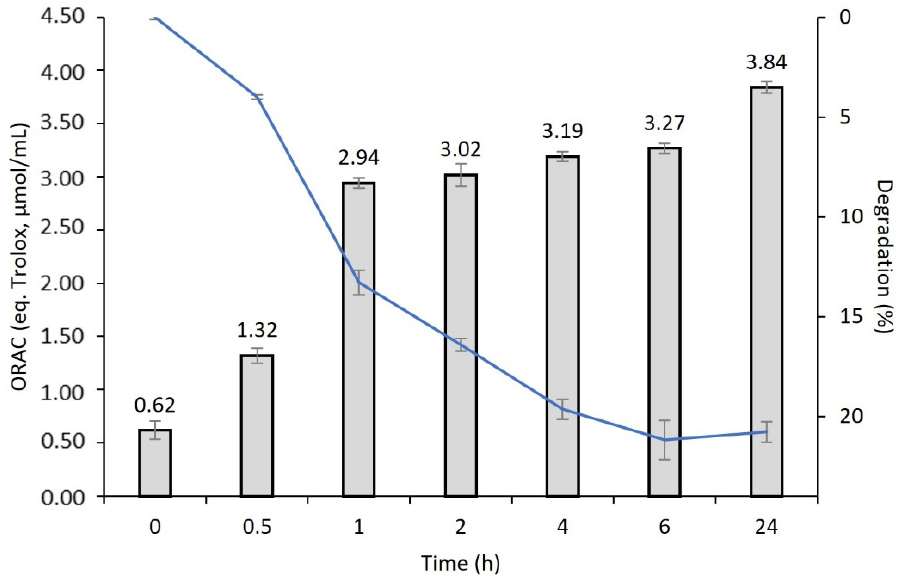
Figure 3. Sericin-based hydrogel antioxidant activity by the ORAC method that were obtained after physiological protease degradation during 24 h at 37 °C.